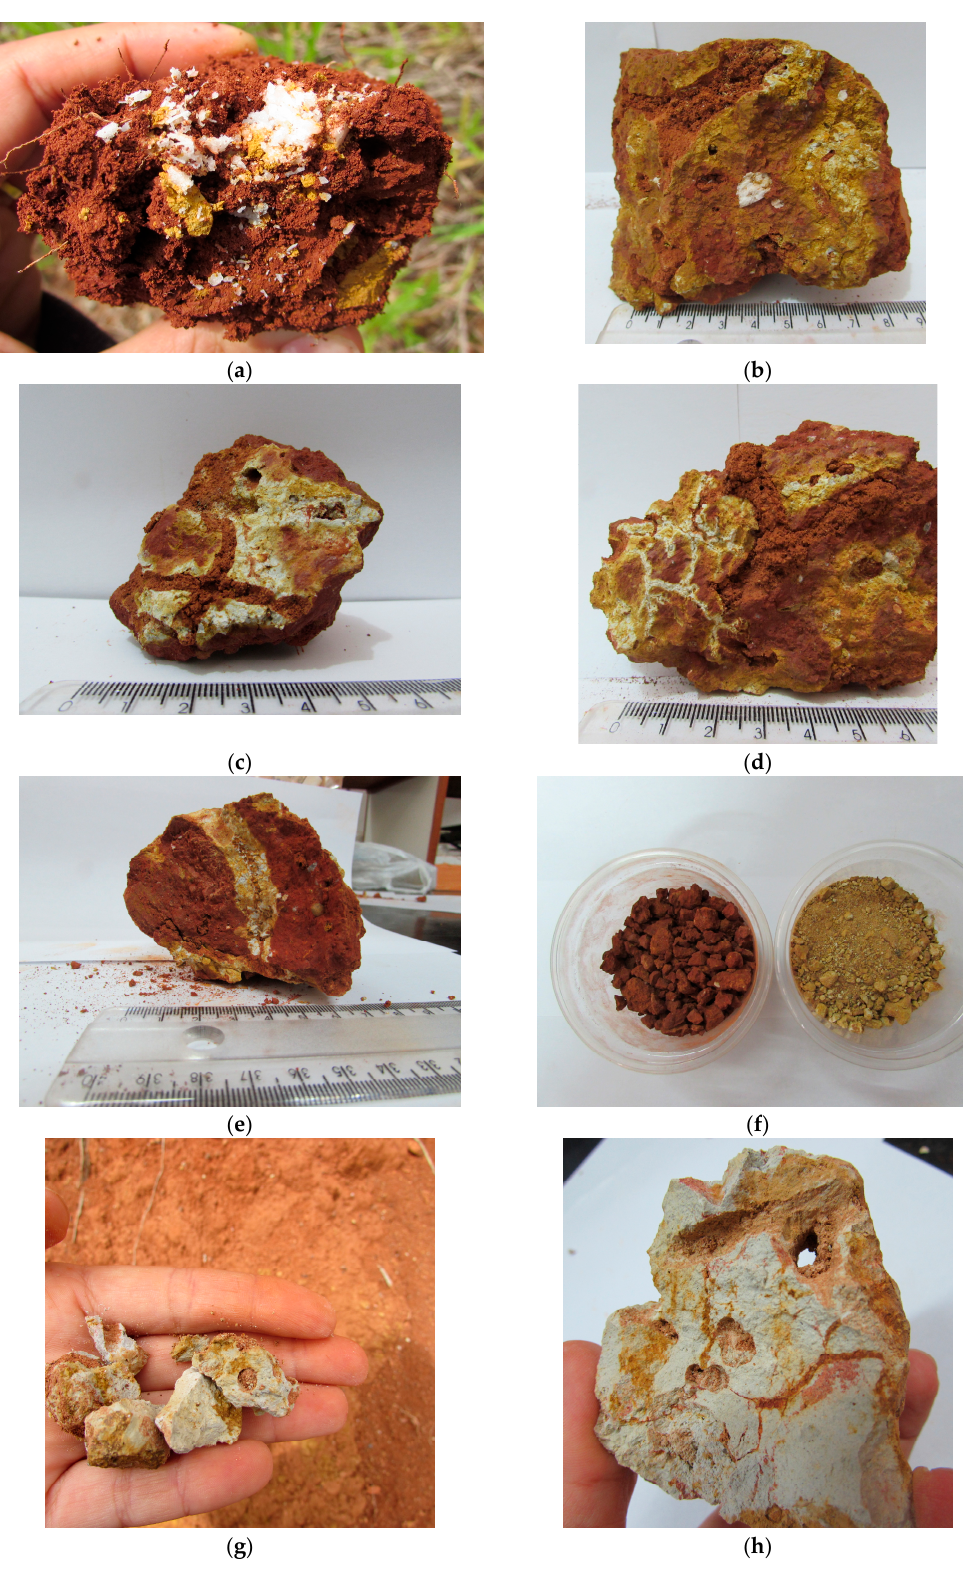
Figure 2. ( a , b ) clods of red–yellow mottles containing masses of clear (with no clay impregnations) quartz, which break with gentle finger pressure into gravel and sand particles; ( c ) crossing channels intersecting a clod surface with varying deferrification; ( d ) partial and total deferrification along clod or ped surfaces, aside from large channels; ( e ) root channel; ( f ) hand-separated matrices; ( g , h ) yellow–white clod with infilled faunal